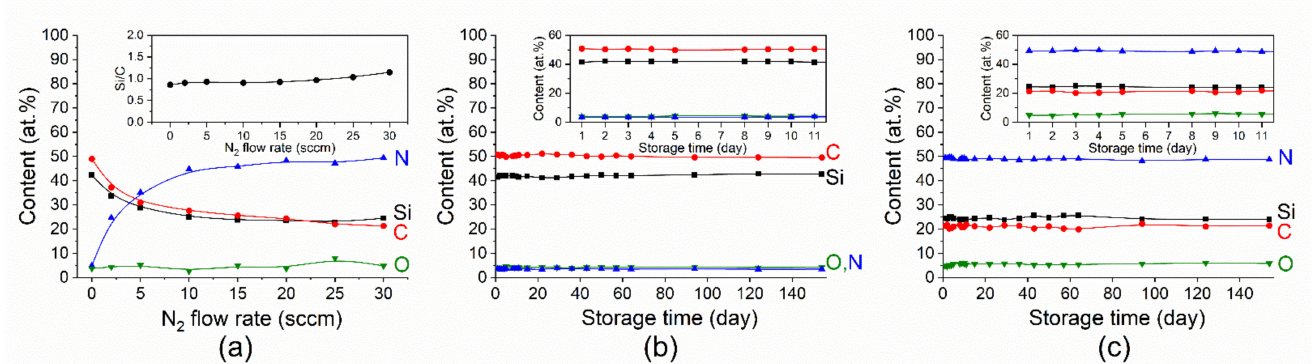
Figure 4. ( a ) The dependence of the elemental composition and the ratio of Si/C elements (insert) in SiC x N y films on the nitrogen flow obtained at room temperature (series A). The element contents in SiC x N y films obtained at ( b ) F(N 2 ) = 0 and ( c ) 30 sccm over time during five months. The insets in ( b , c ) shows the elemental composition during the first storage days.